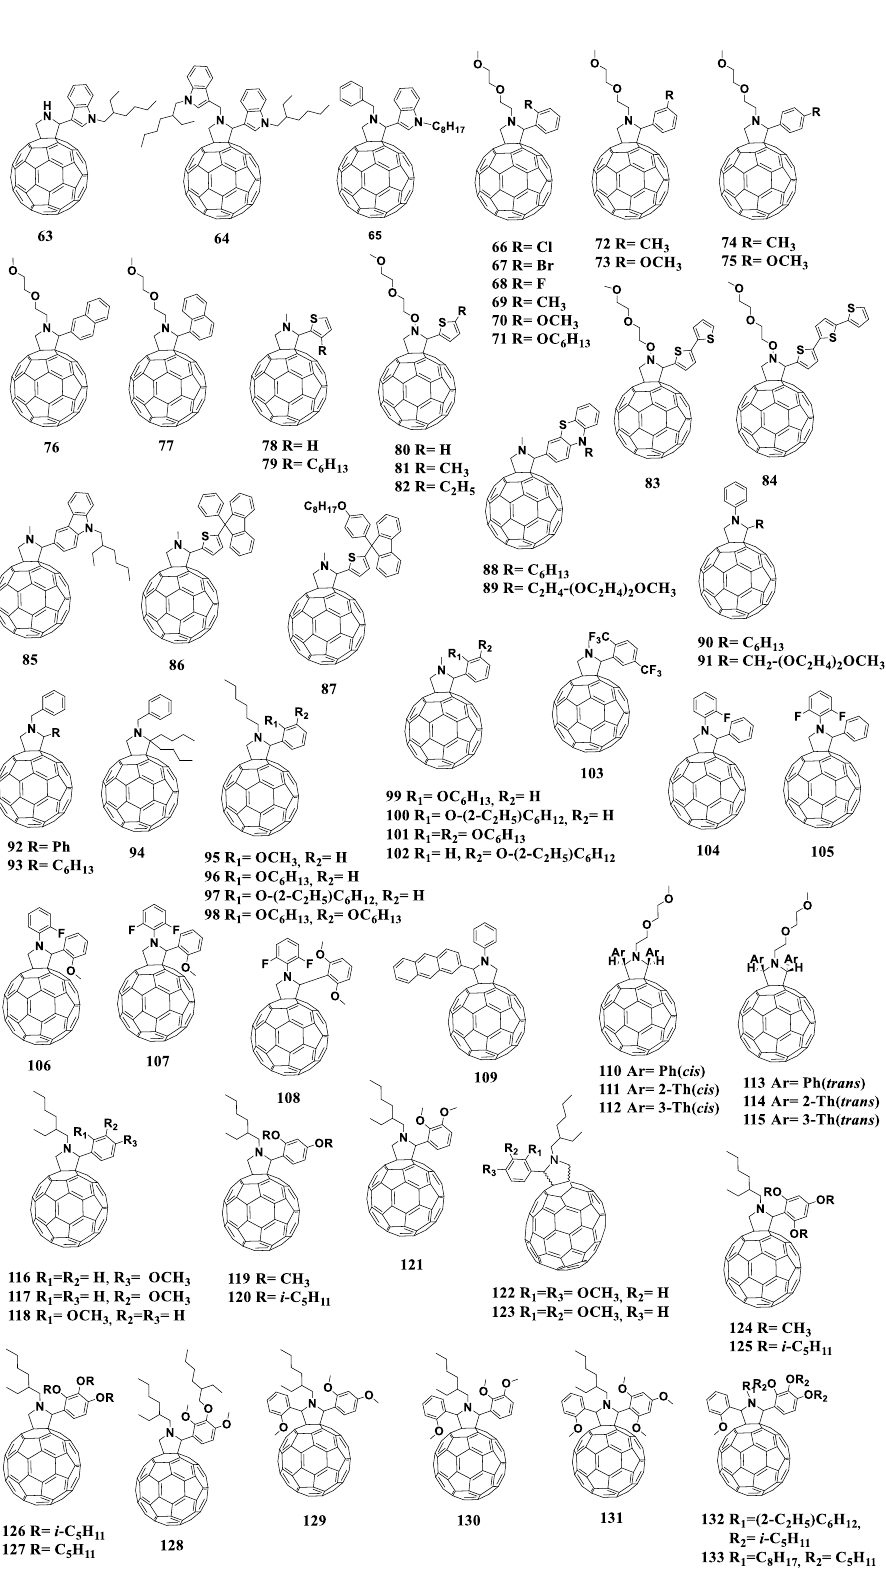
Figure 13. Molecular structures of pyrrolidinofullerenes with reduced electron affinity. Compound 78 contains the thiophene fragment attached to the pyrrolidine ring